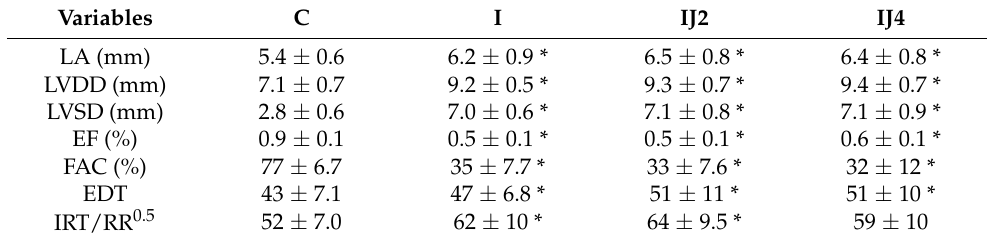
Table 2. Echocardiographic data.